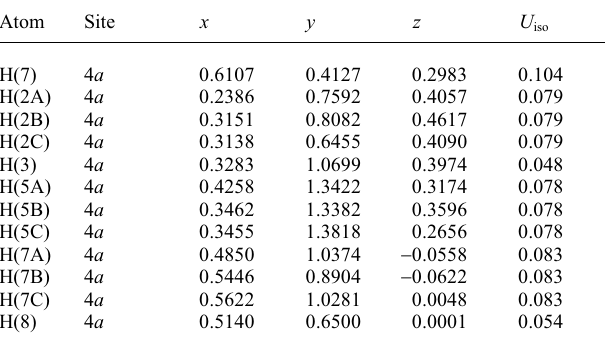
Table 2. Atomic coordinates and displacement parameters (in Å 2 )